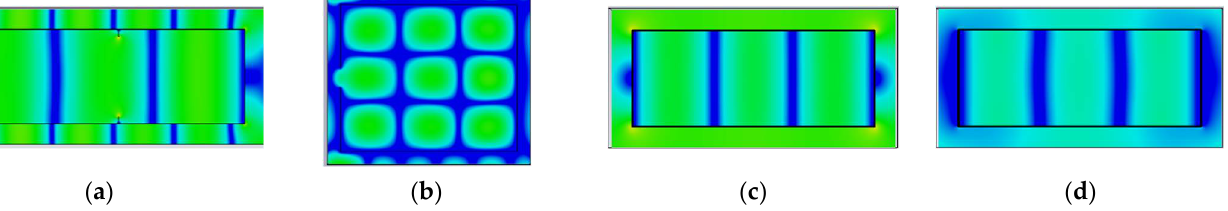
y section, ( c ) z section of the front part, and ( d ) z section of the back part.